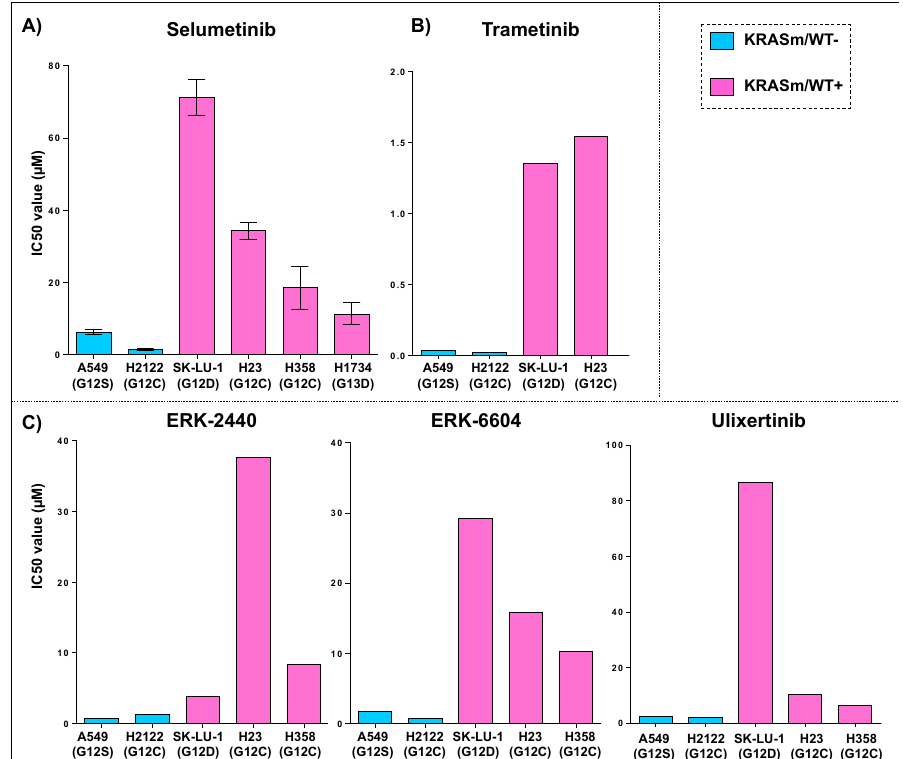
Figure 2. Sensitivity to MEK and ERK inhibitors in KRASm/WT − and KRASm/WT+ adenocarcinoma cell lines. IC50 values for KRAS mutant cell lines treated with a kinase inhibitor targeting KRAS downstream substrates are displayed as bar graphs where cell lines are color-coded based on the presence (KRASm/WT+ pink) or absence ( KRASm/WT − blue) of the KRAS WT allele. IC50 average values ( n = 4) and standard error of the mean after incubation with the MEK inhibitor Selumetinib for 72 h are displayed ( A ); models harboring KRASm/WT − mutations are more sensitive to MEK inhibition compared to cell lines retaining the wild-type copy of the KRAS allele ( A ). These trends were confirmed using data retrieved from the Genomics of Drug Sensitivity in Cancer (GDSC) database for the MEK inhibitor Trametinib ( B ) and the ERK inhibitors Ulixertinib, ERK6604 and ERK2440 ( C ). Single IC50 values are available for each compound on the GDSC database.